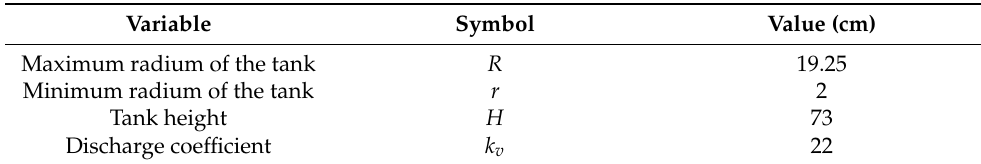
Table 1. Tank Table 1. Tank parameters.